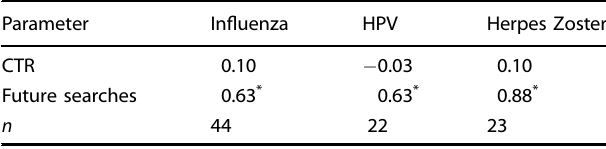
Table 2. Correlation of term similarity with CTR and with the percentage of future searches for the